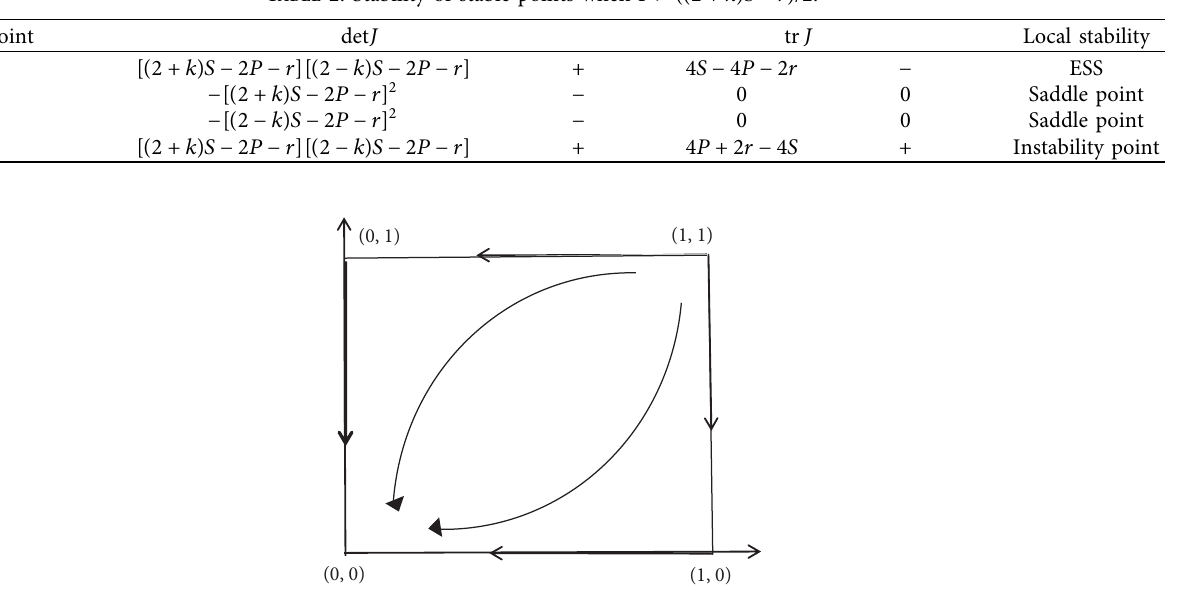
Figure 1: Dynamic diagram of evolution phase when P > (( 2 + k ) S − r ) /2. Table 3: Stability of stable points when (( 2 − k ) S − r ) /2 < P < (( 2 − k ) S − r ) /2. Stable point det J tr J Local stability